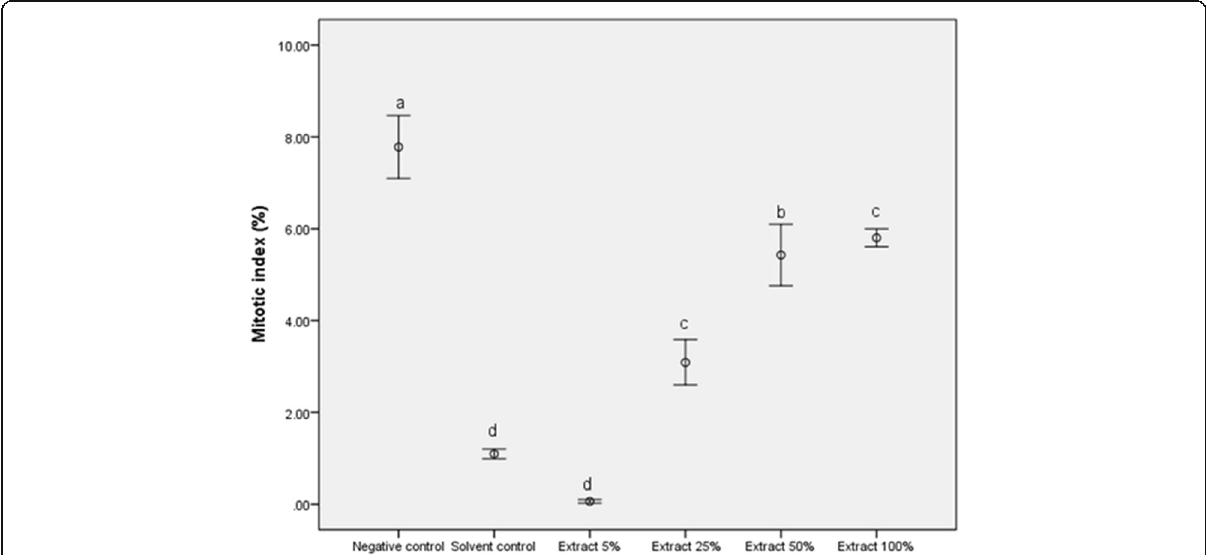
Fig. 4 Mitotic indices induced by hydro-alcoholic extracts of J. communis L. in root tip cells of A. cepa L. (bars represent the standard error; a, b, c, d: the interpretation of the significance of the differences by means of the Duncan test, p ˂ 0.05)